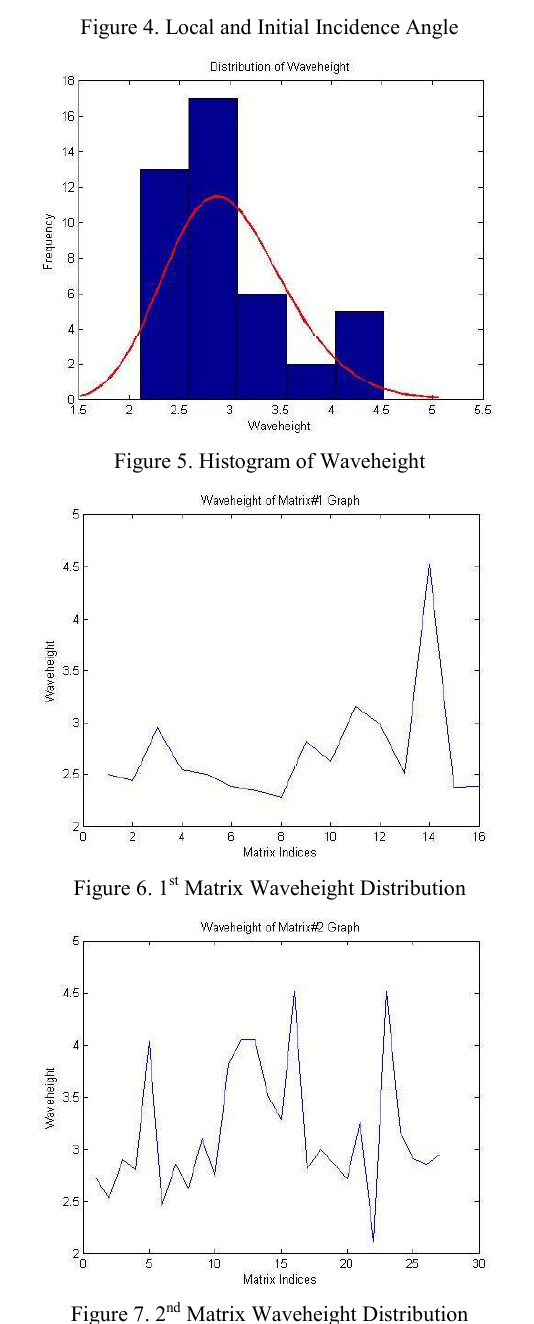
Figure 7. 2 nd Matrix Waveheight Distribution